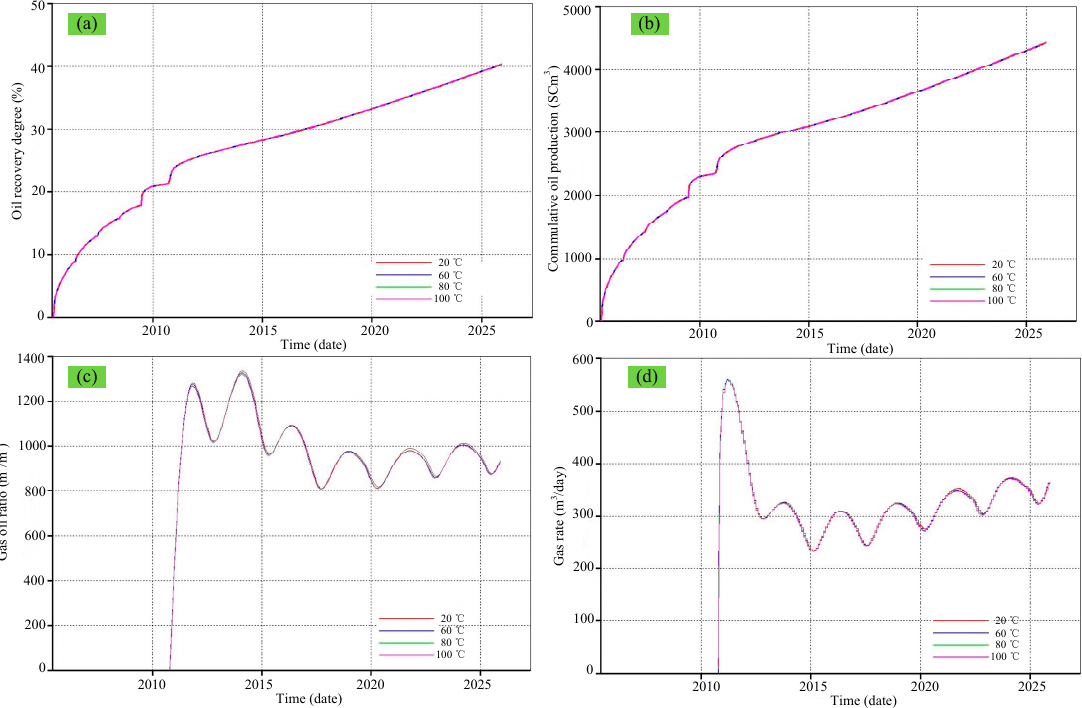
Figure 6. Comparison of production indicators under different air injection temperatures. ( a ) Recovery degree; ( b ) cumulative oil production; ( c ) gas-oil ratio; and ( d ) gas production rate.